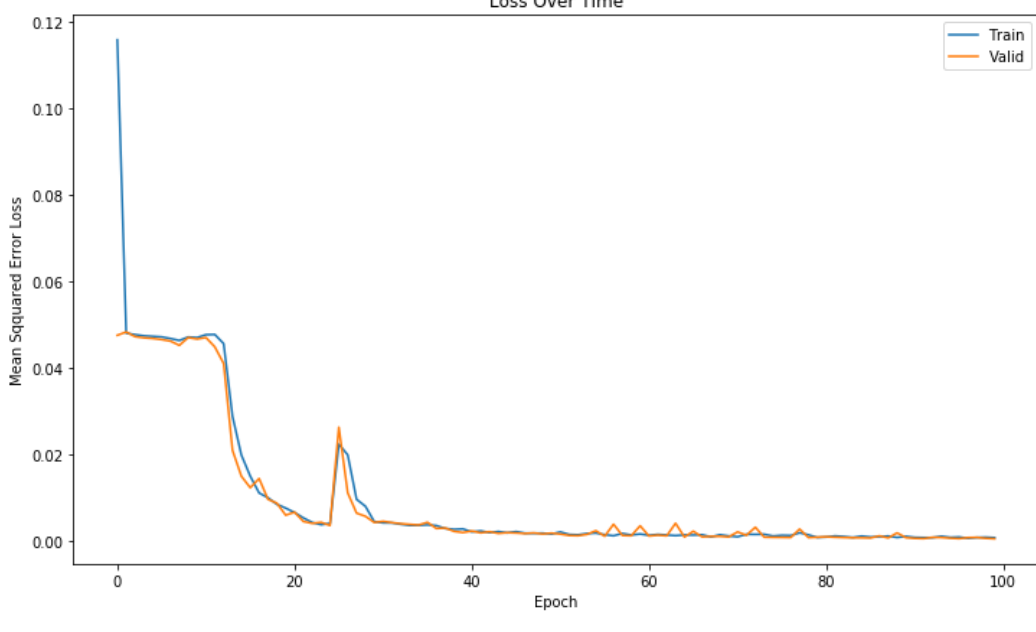
Figure 6. Training vs. validation loss